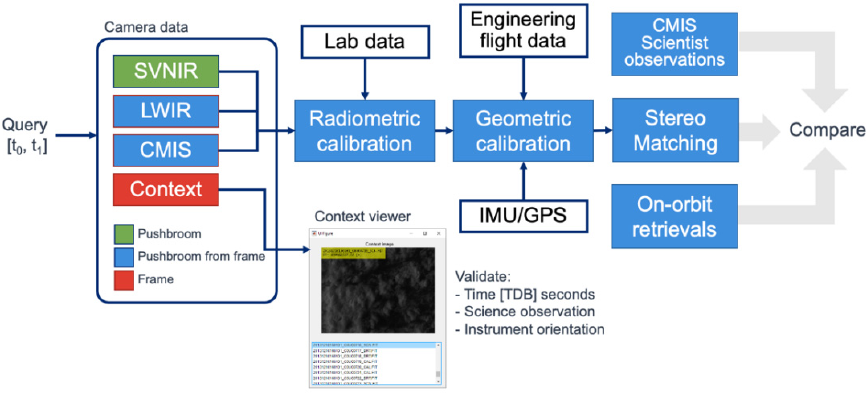
Figure 6. Depiction of the aircraft data collection and processing